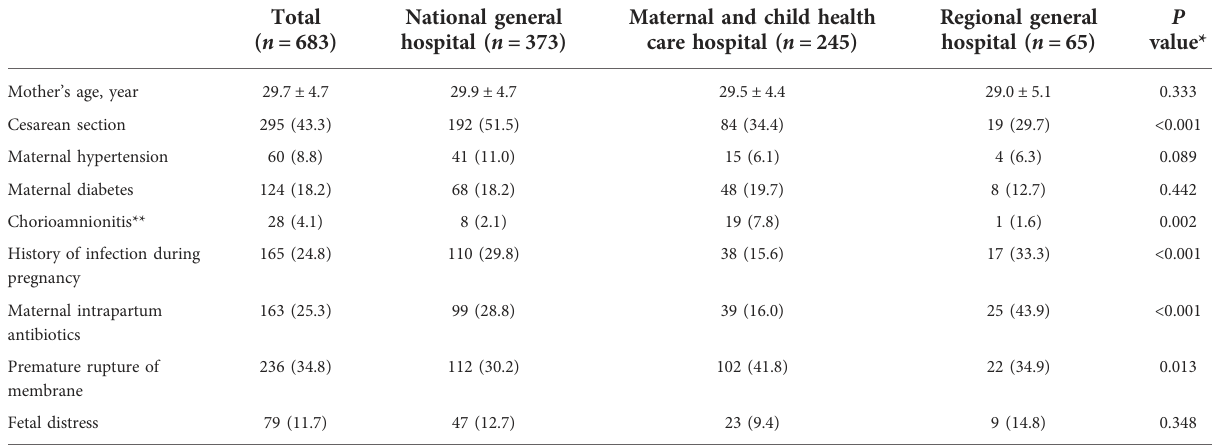
TABLE 5 Maternal characteristics of neonates with culture-proven sepsis.